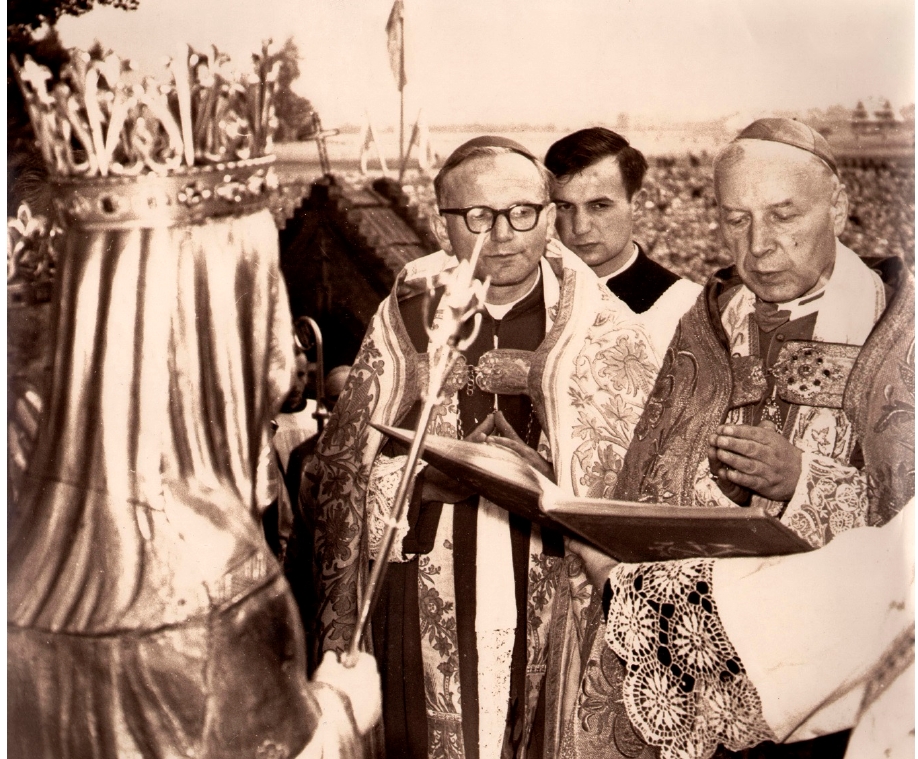
Figure 11. The Primate of Poland, Cardinal Stefan Wyszy ń ski, crowns the statue of Our Lady of Lud ź mierz—Queen of Podhale in Lud ź mierz. Next to Primate Wyszy ń ski, Card. Karol Wojtyla (15 August 1963). (photo: Archives of the Shrine of Our Lady of Lud ź mierz—Queen of Podhale in Lud ź mierz).